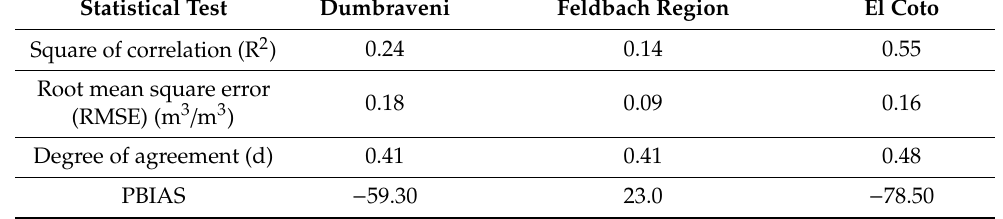
Table 4. Results of comparison between the in situ and SMAP data set at selected sites in Europe.